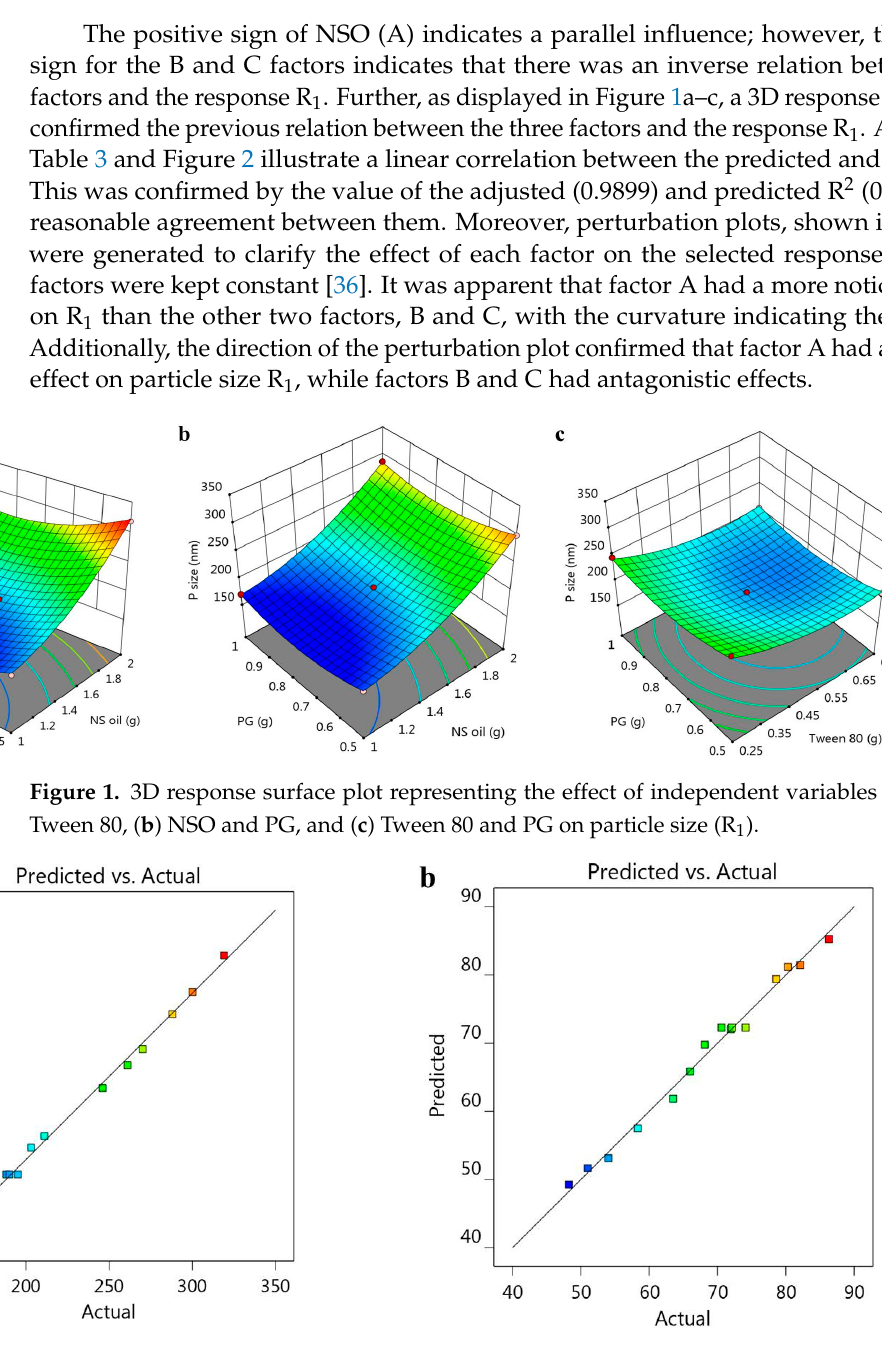
Figure 3. Perturbation plots displaying the influence of each independent variable alone on ( a ) particle size R 1 , and ( b ) in vitro release R 2 . 3.2.2. Response 2: Influence of the Independent Variables on R 2 An in vitro release study was conducted for all PGZ-loaded NE formulations with release values ranging between 48.2 ± 3.1 and 86.3 ± 2.9% after 12 h, as shown in Table 2. It was clear that NSO indirectly affected the percentage of PGZ released from the NE formulation, with increasing NSO resulting in a lower R 2 percentage. This might be attributed to the larger particle size, since increasing oil concentration would cause a relative increase in NE particle size, providing a small surface area, lowering the percentage release from the formulation [37]. However, with a constant concentration of NSO, it was noted that increasing surfactant (B) and co-surfactant (C) concentrations enhance PGZ release from the developed NE. This may have been a result of the surfactant lowering the interfacial tension between the formulation and the surrounding aqueous media of release. This would allow for more wetting of the drug, facilitating penetration,